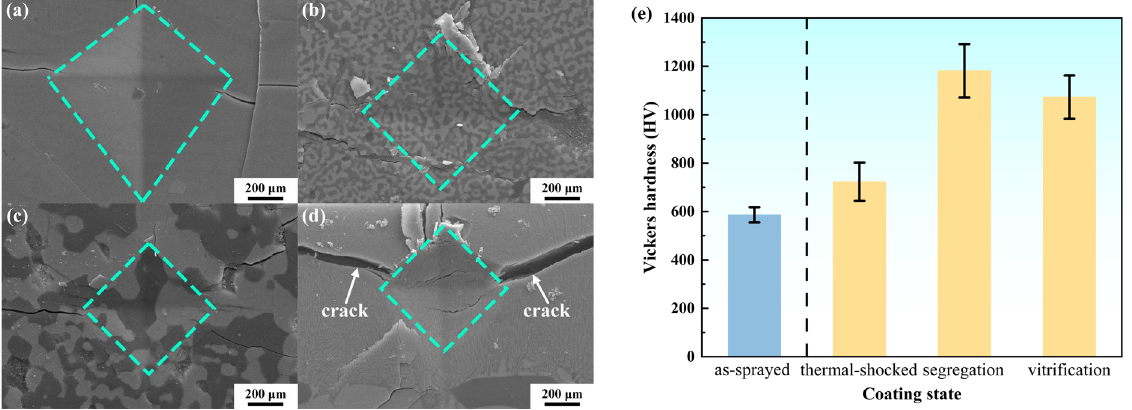
Figure 9. Typical indentation morphologies of Al 2 O 3 -GAP coating in different states ( a ) as-sprayed, ( b ) thermal-shocked, ( c ) segregation, and ( d )vitrification, and their ( e ) Vickers hardness.